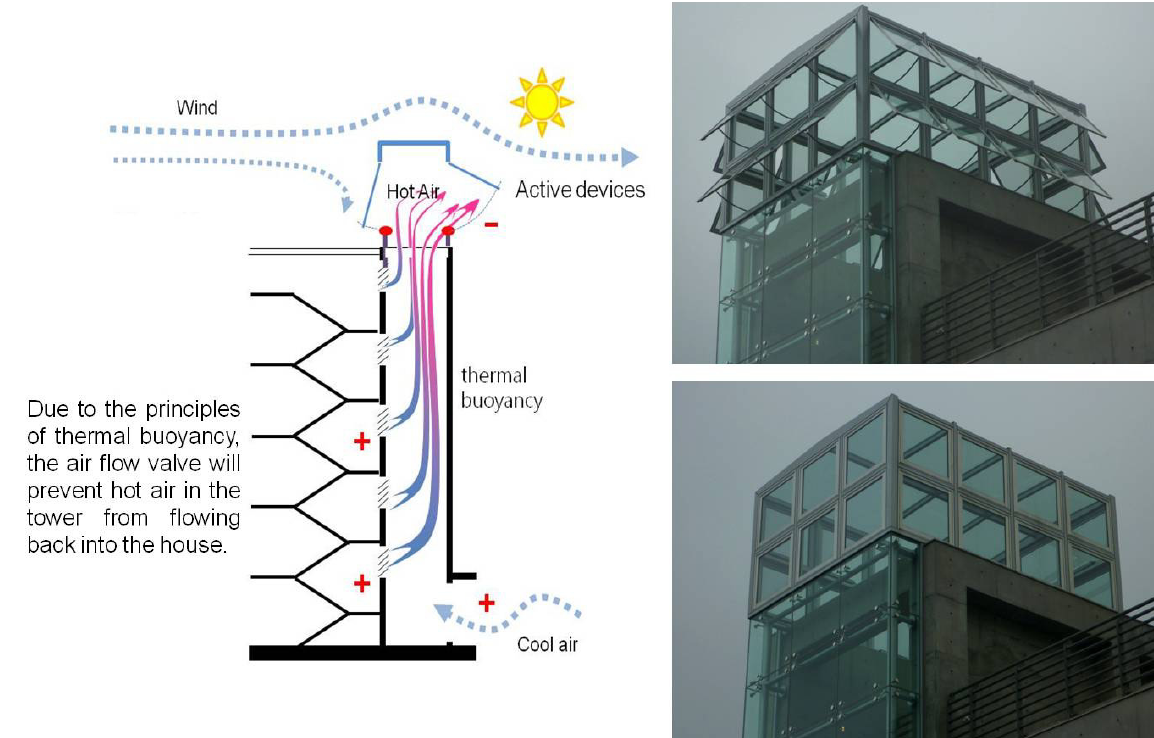
Figure 7. Operating principle of the thermal buoyancy ventilation tower and control of air